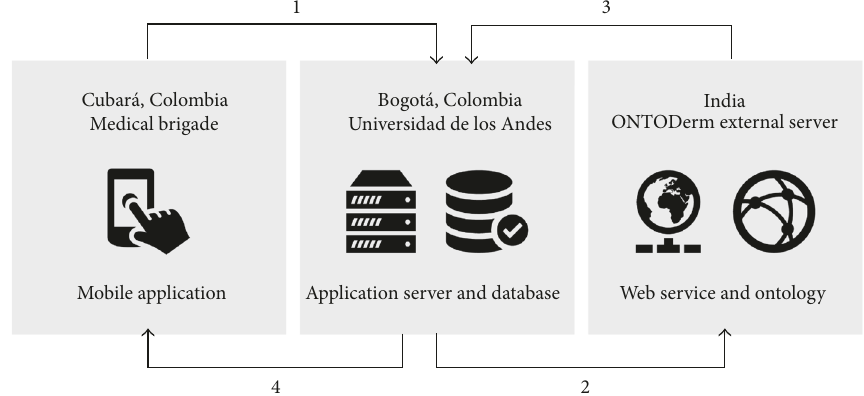
Figure 1: Skinhealth overall perspective view.